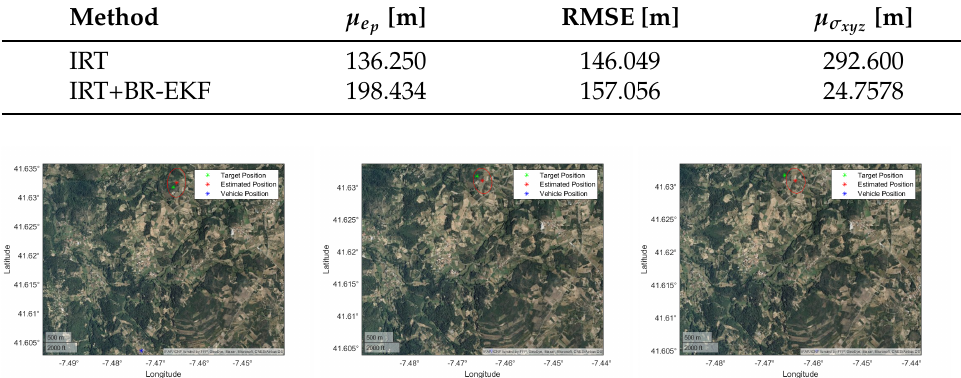
Figure 18. Portuguese Air Force footage georeferencing results displayed on a satellite view of the terrain. The red marks and ellipses show, respectively, the IRT measurement and the estimated uncertainty computed by the UT in three sample frames of the video.